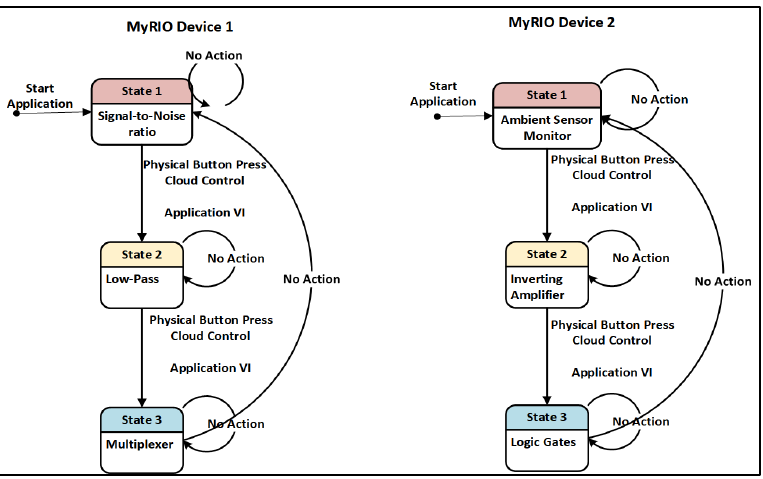
Figure 6. State machines running on different MyRIO devices.